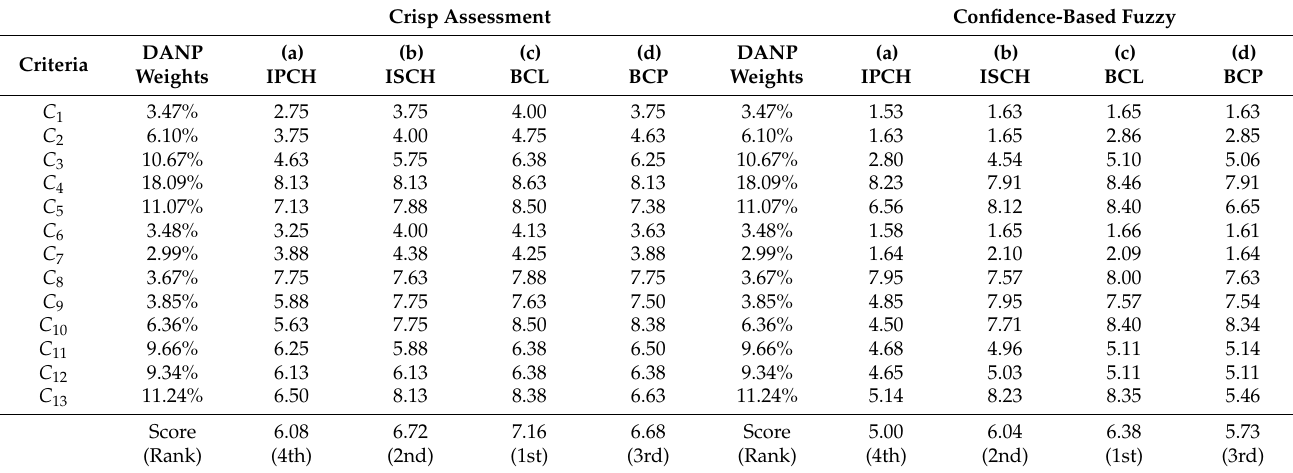
Table 8. DANP weights and SAW ranking